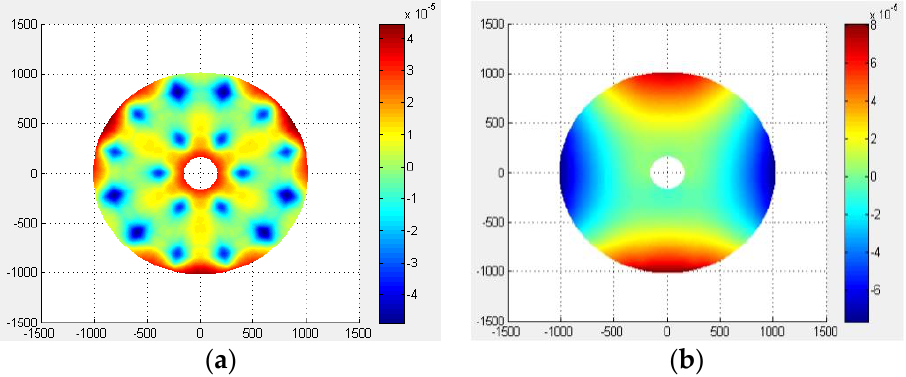
Figure 11. Surface error of the PM under the gravity field when ( a ) the optical axis is vertical and ( b ) the optical axis is horizontal.